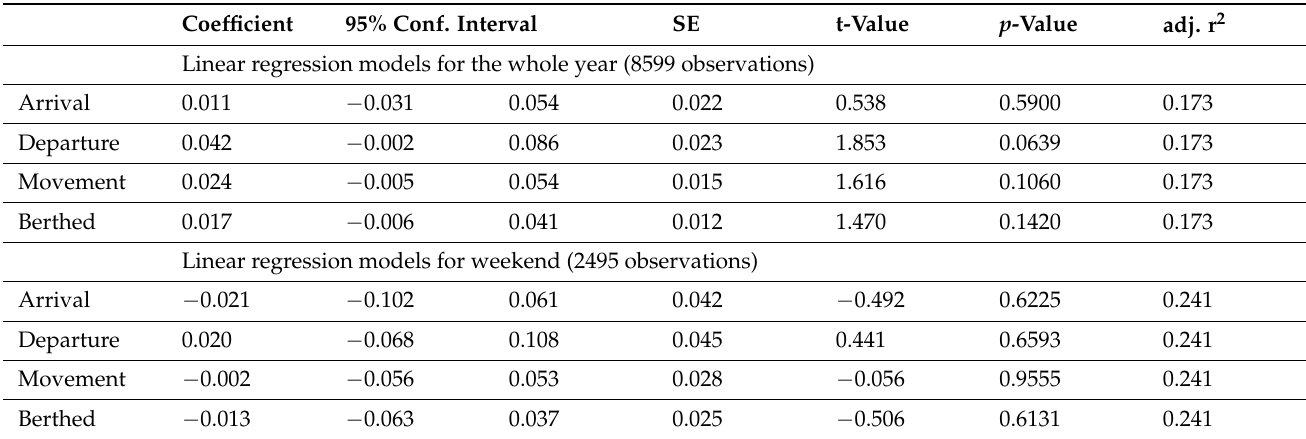
Figure 15. Time variation plot of hourly mean PM 2.5 concentrations at the Katajanokka terminal in 2021. Table 13. Multivariable linear regression analysis results for vessel arrivals, departures, movement and laying alongside to the logarithm of PM 2.5 hourly mean concentrations controlled for wind direction, wind speed, relative humidity, air temperature and time of day at Katajanokka in